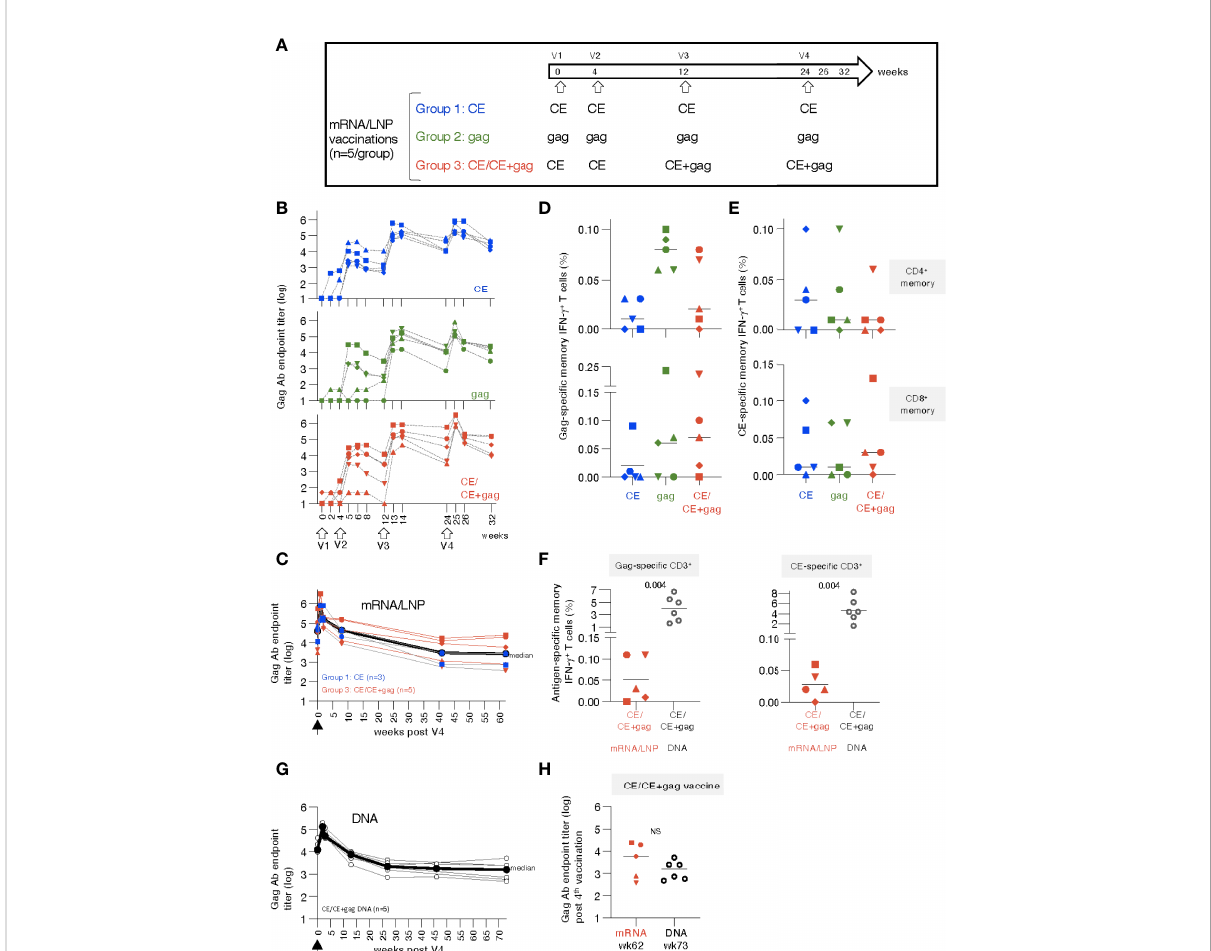
FIGURE 1 mRNA/LNP vaccination of naïve rhesus macaques induces robust antibody and low T cell responses. (A) Schematic representation of the HIV-1 mRNA/LNP vaccination regimens of the three groups receiving four vaccinations (V1 to V4) with the indicated gag immunogens. (B) Plots showing the vaccine-induced Gag Ab measured over time as reciprocal endpoint titers (log). (C) Durability of CE and CE+gag mRNA/LNP vaccine induced Gag antibodies. Gag Ab titers were plotted from eight vaccinated macaques [group 1, n=3 (CE mRNA/LNP), blue symbols; group 3, n=5, red symbols; (CE/CE+Gag mRNA)] described in panel B over 62 weeks post the last vaccination (V4). Black symbols denote median antibody titers. (D, E) Antigen-speci fi c T cell responses by fl ow cytometry measured two weeks after the 4 th vaccination. (D) Gag- speci fi c and (E) CE-speci fi c memory (CD3 + CD95 + IFN- g + ) T cell responses were measured 2 weeks after the 4 th vaccination. (F) Comparison of memory T cell responses in macaques immunized with the mRNA/LNP regimen (group 3) and the homologous DNA vaccine regimen from historical samples (30) at two weeks post vaccination 4. The data were obtained in the same fl ow cytometer (BD Fortessa) using the same antibody panel and the same gating strategy in these two groups of samples and included an internal positive control. This approach excluded any variability associated with instrument and/or reagent performance. P values are from unpaired t test (Mann-Whitney). (G) The CE/CE+gag DNA vaccine (dose: 2 mg prime, 2 + 2 mg boost) contained IL-12 DNA as vaccine adjuvant and was administered by IM injection followed by electroporation using the same schedule for the matching the mRNA/LNP. Plot showing Gag Ab responses after the 4 th vaccination. The last time points of blood collection were weeks 70 and 76, respectively, for 3 animals each and these time points were combined plotted as week 73. (H) Comparison of Gag antibody titers (log) in macaques receiving CE/CE+Gag vaccine as mRNA/LNP (wk 62) and DNA (wk 73) vaccine post the 4 th vaccination,